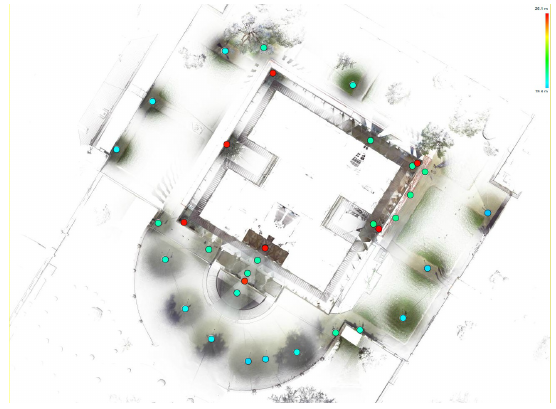
Figure 2. Scheme for acquisition points with overlapping of images in the project for the photogrammetric survey.